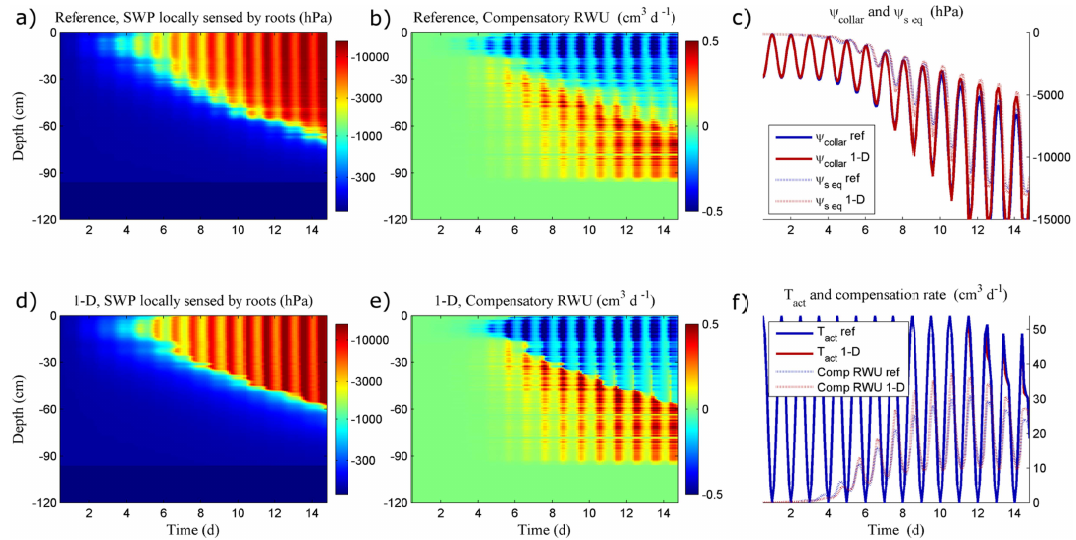
Fig. 8. Spatio-temporal distribution of (a, d) SWP locally sensed by roots and (b, e) compensatory RWU rates (spatial integration of positive terms), respectively in reference and 1-D scenarios. Temporal evolution of (c) plant collar water potential and SWP sensed by the plant, and (f) actual transpiration and compensation rates (scenario: winter wheat, high T daily on sandy